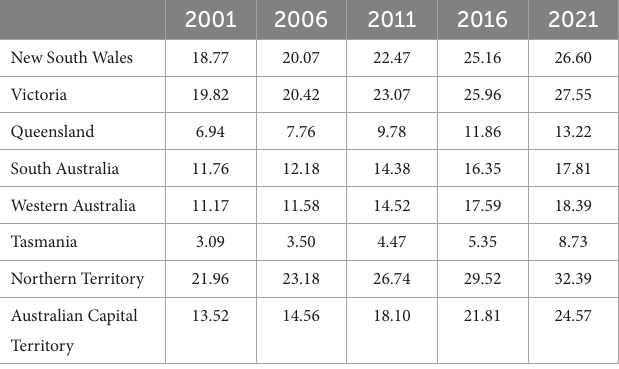
TABLE 2 Proportion (%) of population speaking non-English language at home by